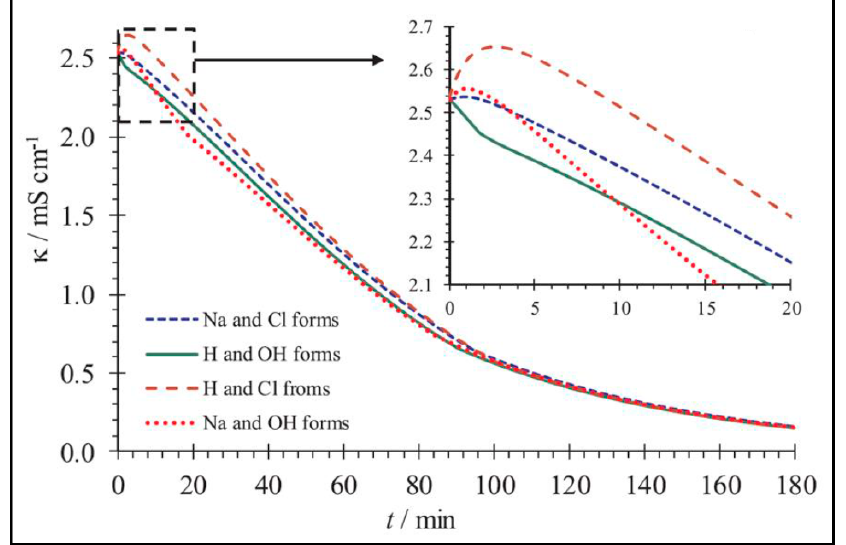
Figure 19. Calculated (using the non-steady state model [15]) time-dependences of the saline solution conductivity of solution ( c ) in the D compartment for various initial states of the CEM and the AEM. Adapted from [15].